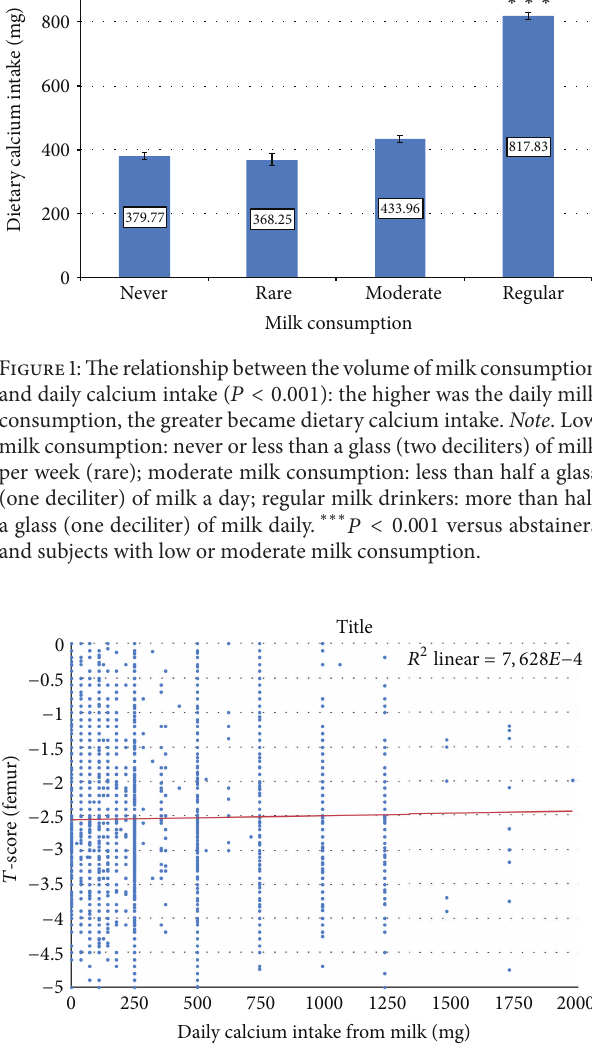
Figure 2: The relationship between the presence of milk consump- tion and the 𝑇 -score of the femur ( 𝑃 = 0.041